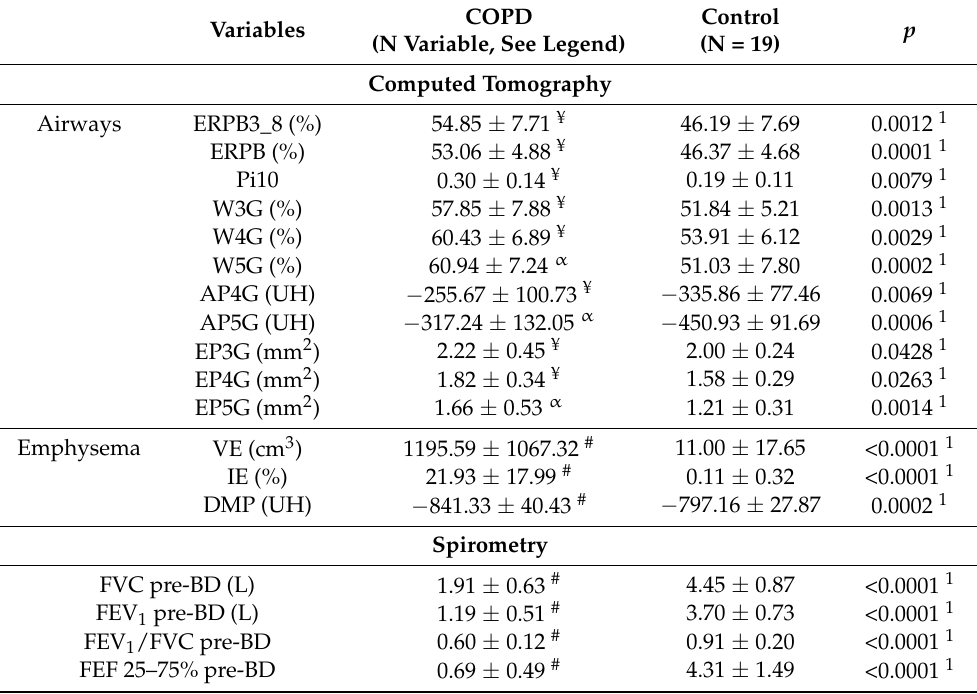
Table 2. Data from CT scans and spirometry of COPD patients and controls.